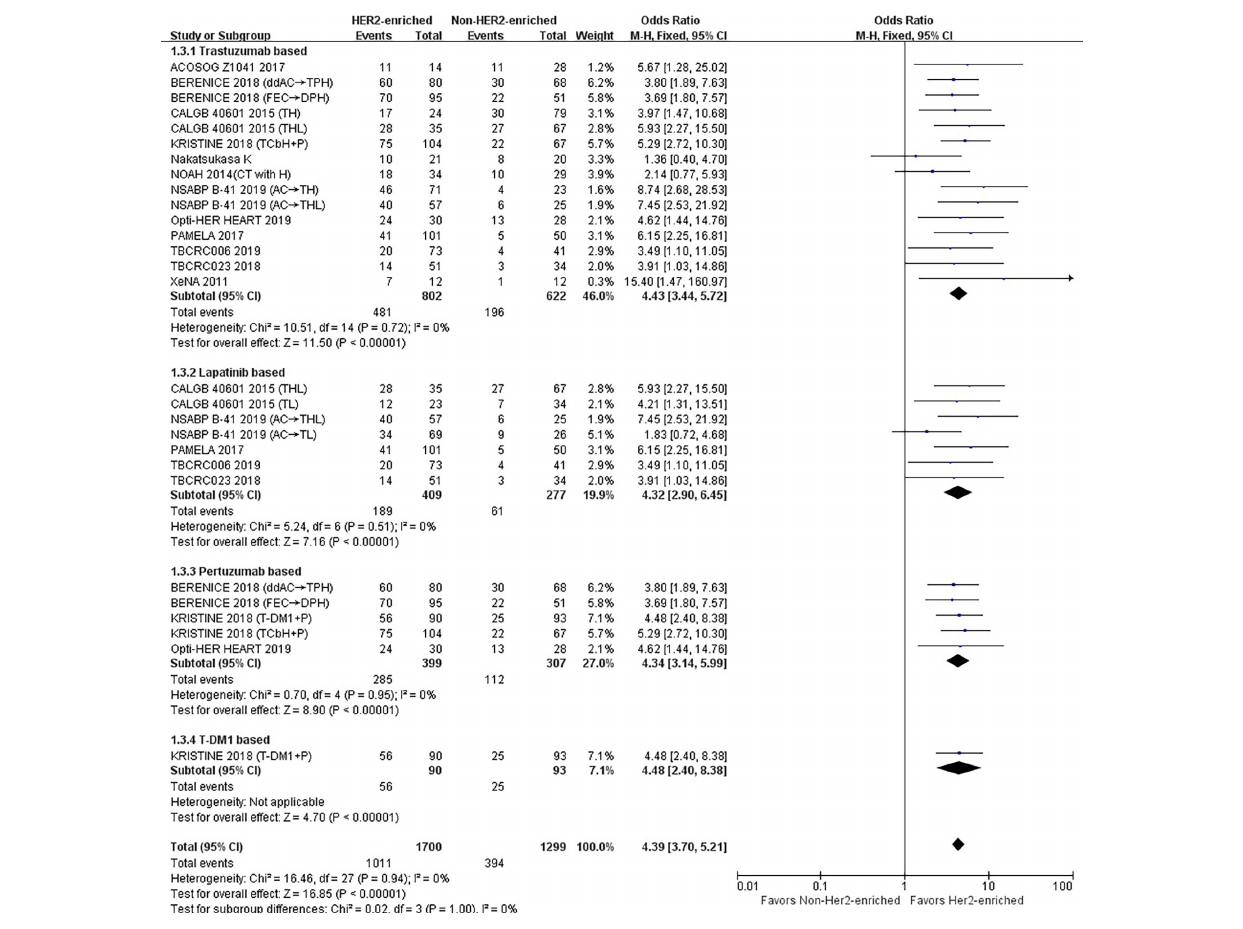
FIGURE 4 | Forrest plot of odds ratio (OR) used to evaluate the correlations between intrinsic molecular subtype subgroups (HER2-enriched vs. non-HER2-enriched) and pCR as based on the category of HER2-targeted therapy used. CI, con fi dence interval; HER2, human epithelial growth factor receptor 2; pCR, pathological complete